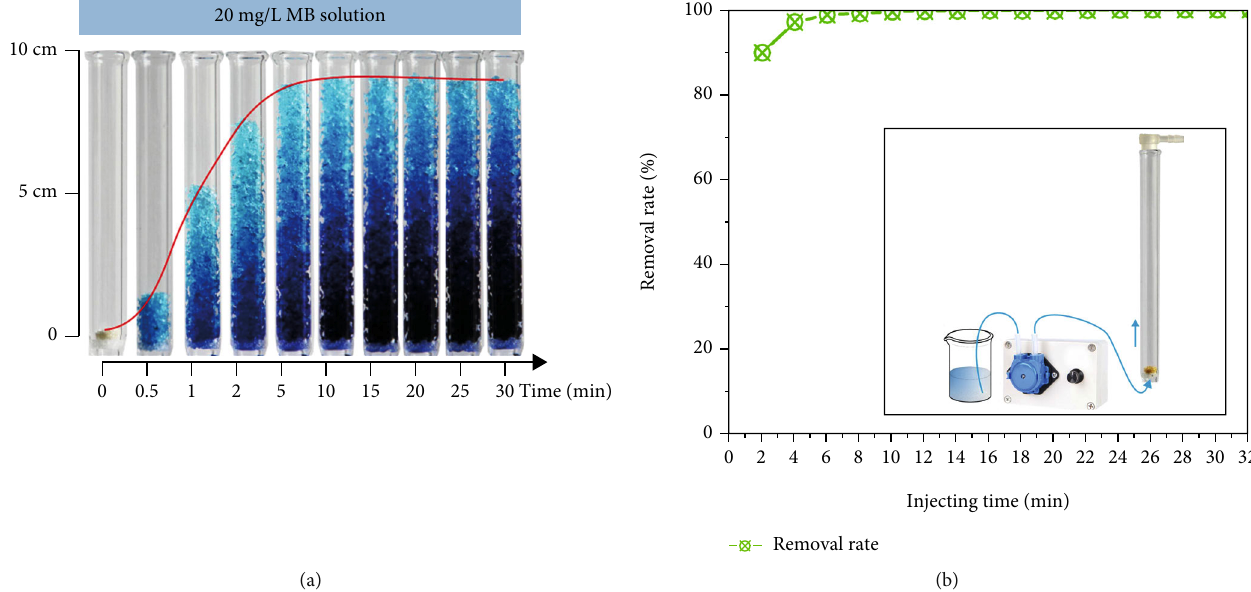
Figure 8: Dynamic changes in P(AANa/AM) morphology and MB removal rates in column adsorption